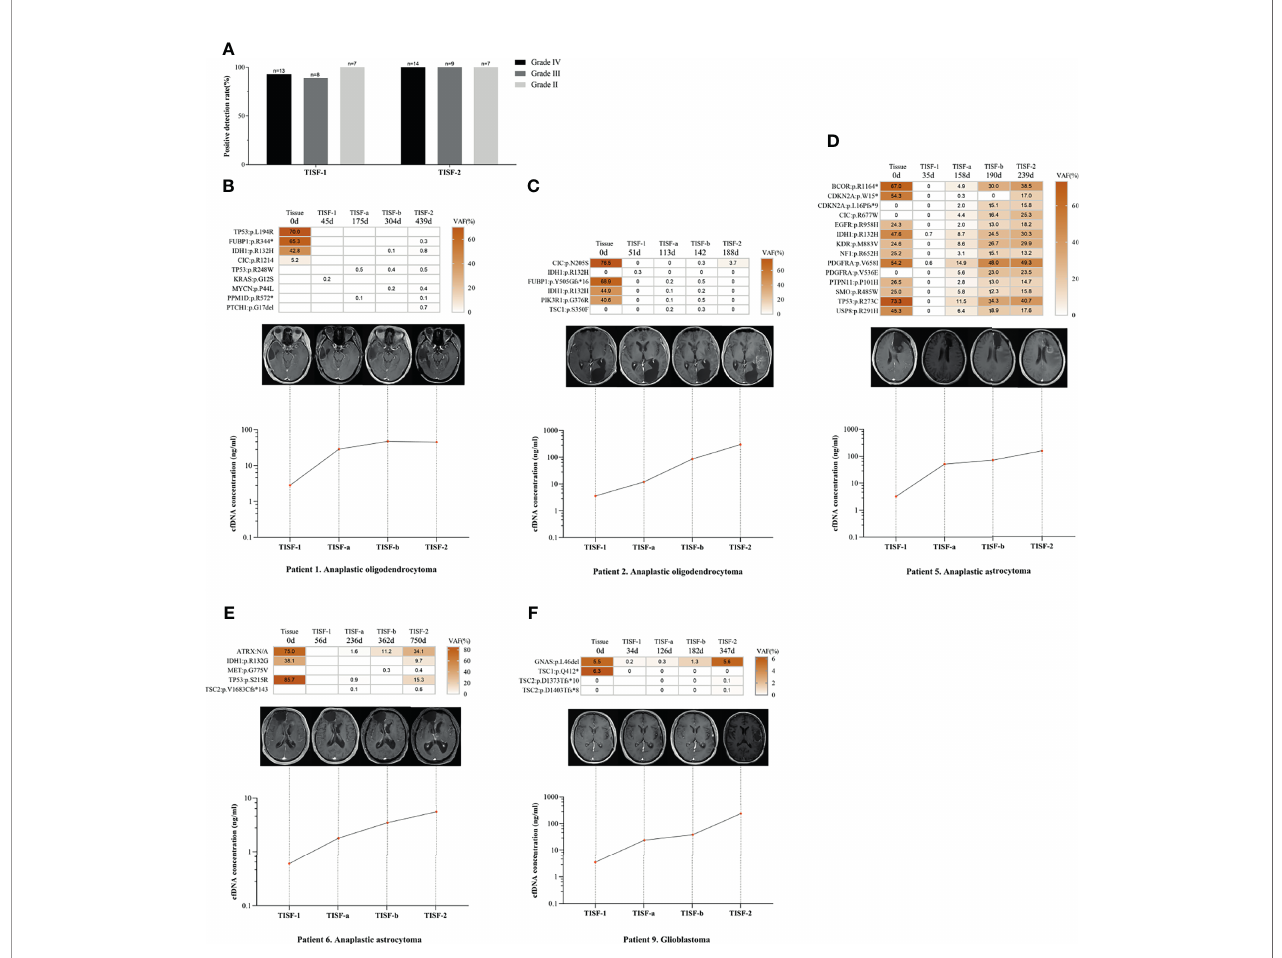
FIGURE 5 | Relationship between tumor DNA derived from TISF and tumor progression. (A) Patients with different tumor grades detected positive for TISF. (B, C) Patients with increased cfDNA concentration and low VAF level when tumor progression. (D – F) The concentration of TISF-cfDNA and VAF continued to increase before imaging tumor